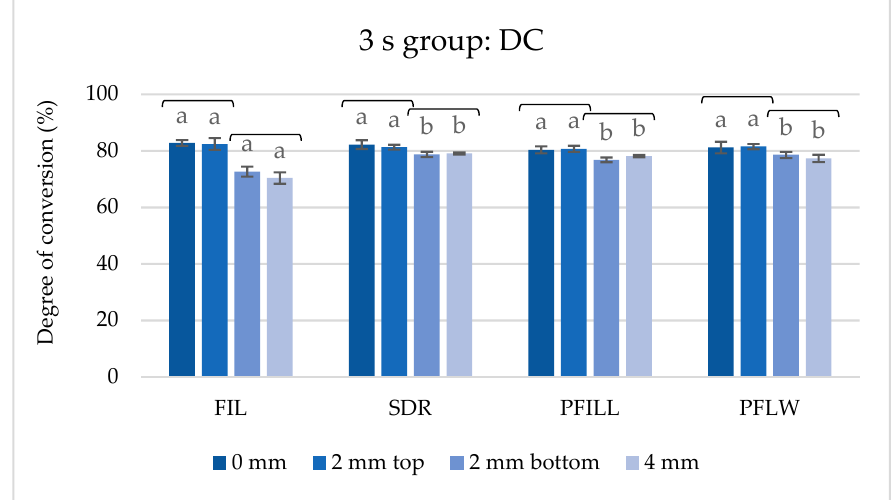
Figure 8. The degree of conversion (%) for materials polymerized with 3 s protocol (mean values ± 1 standard deviation). The same letters indicate statistically homogeneous groups for a single depth, while brackets indicate statistically homogeneous groups for a single material ( p < 0.05).